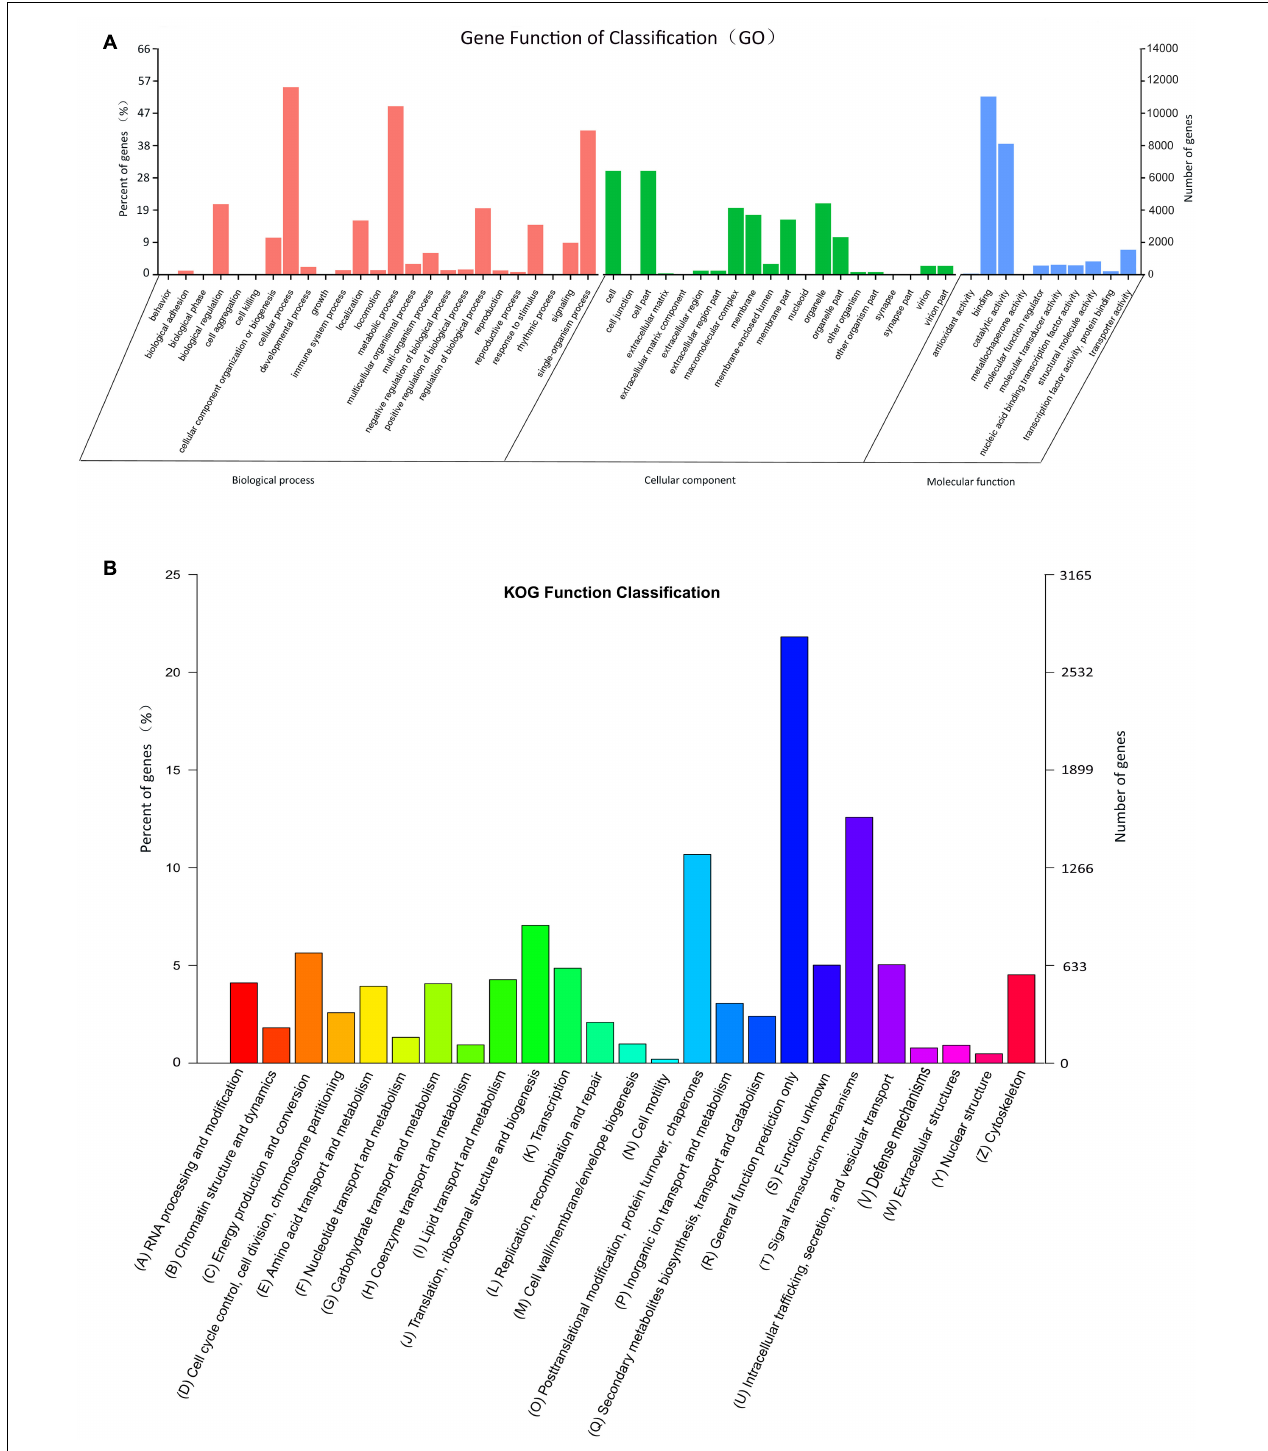
FIGURE 2 | Histograms of gene ontology (GO) classifications (A) and clusters of orthologous groups of proteins (KOG) (B) . (A) The GO classifications are summarized into three main categories: biological processes, cellular component, and molecular function. The right y -axis indicates the number of genes in a category, and the left y -axis indicates the percentage of genes in a specific term in that main category. (B) The x -axis indicates 26 categories. The left y -axis indicates the percentage of a specific gene classification in that main category, and the right y -axis indicates the number of genes in a category.